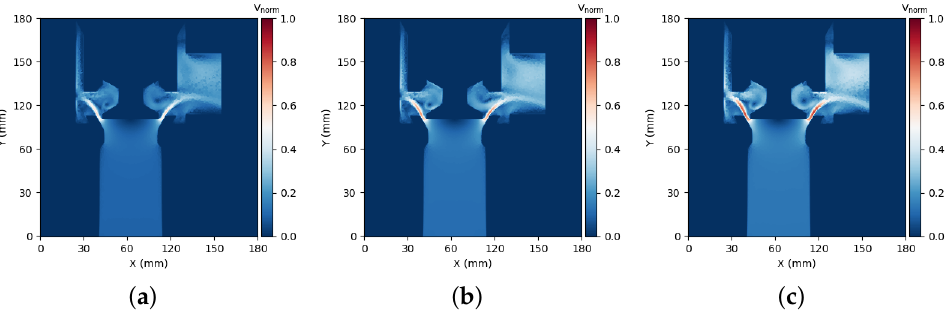
Figure 10. Discharging valve velocity field under different pressure differences. ( a ) ∆ p = 4 bar; ( b ) ∆ p = 6 bar; ( c ) ∆ p = 8